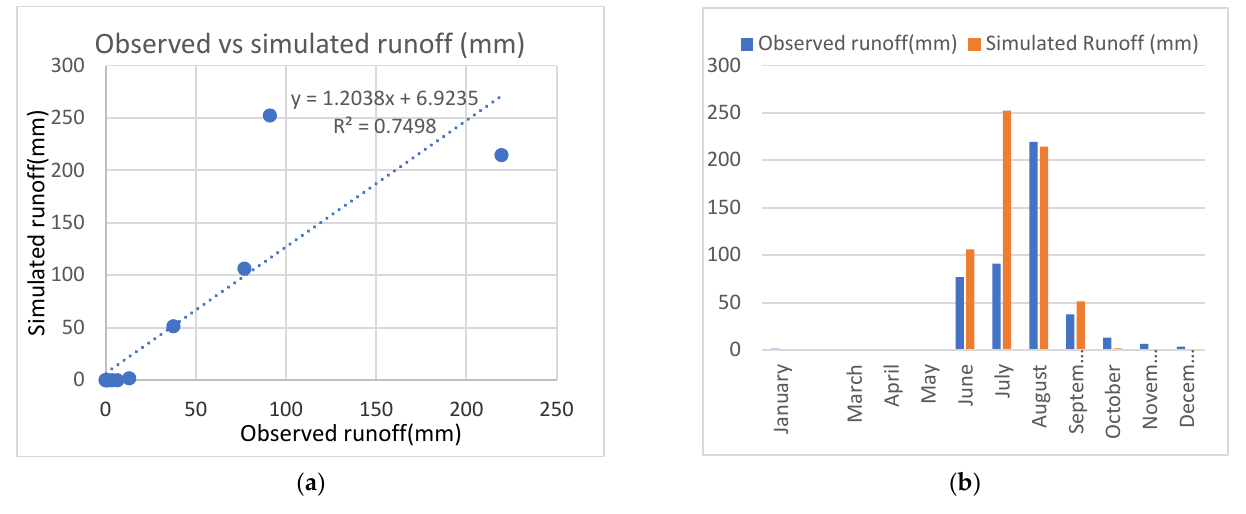
Figure 6. Model validation runoff (2003–2004). ( a ) Observed versus simulated runoff; ( b ) Mean monthly observed and simulated runoff depths.